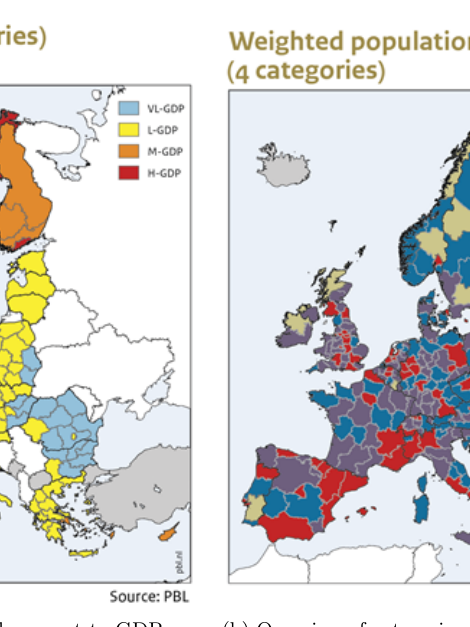
Figure A.1: Categories of regions